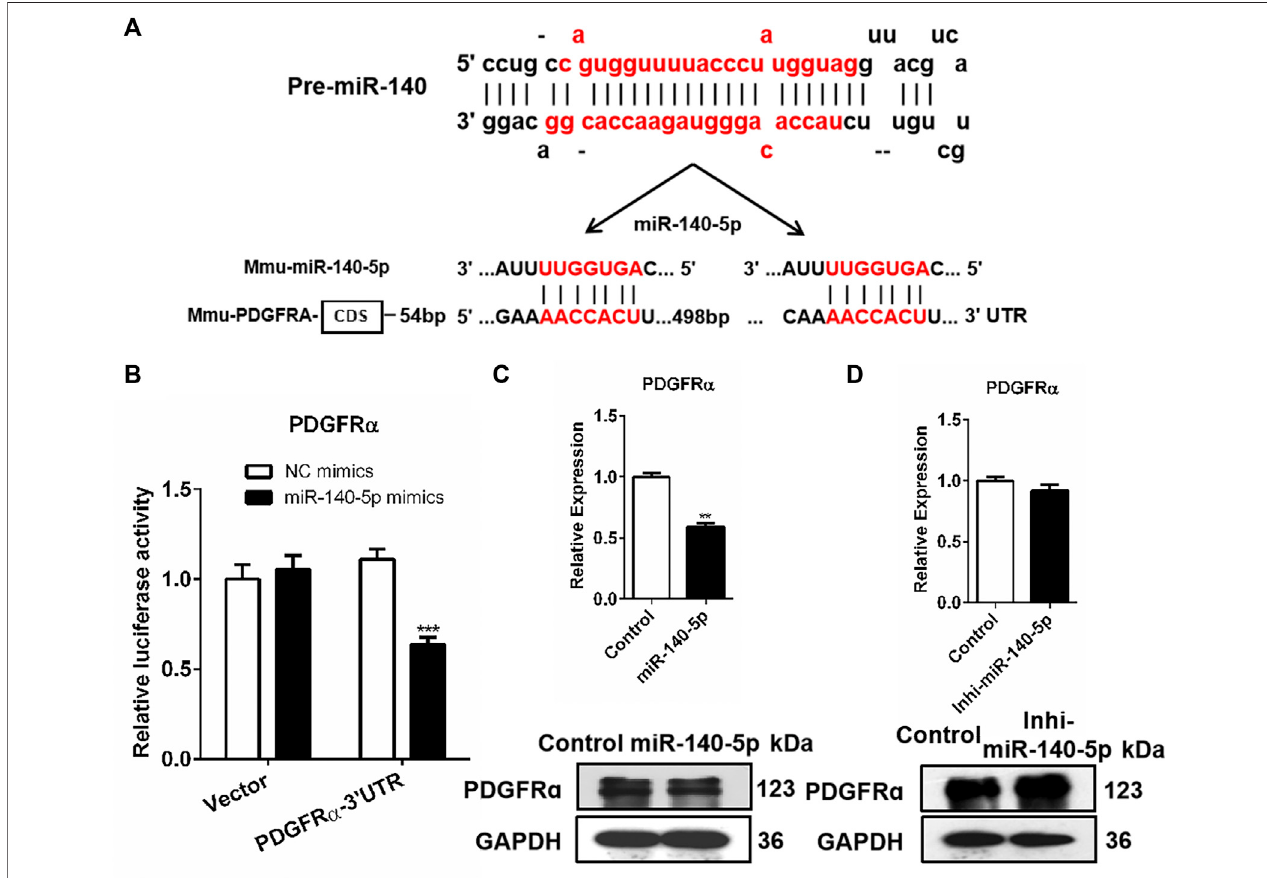
FIGURE 3 | PDGFR α as a direct target of miR-140-5p. (A) Docking site sequence of miR-140-5p to 3 ′ UTR of PDGFR α gene according to the TargetScan database. (B) Relative luciferase enzyme activity of PDGFR α -3 ′ UTR vector and control vector after co-transfection with miR-140-5p mimics (miR-140-5p) or negative controlmimics(Control)inHEK293Tcells. (C) PDGFR α mRNAandproteinlevelsaftertransienttransfectionof3T3-L1cellswithmiR-140-5pmimicsorcontrolbasedon qRT-PCR and Western blot. (D) PDGFR α expression levels after transient transfection of 3T3-L1 cells with miR-140-5p inhibitors (Inhi-miR-140-5p) or control based on qRT-PCR and Western